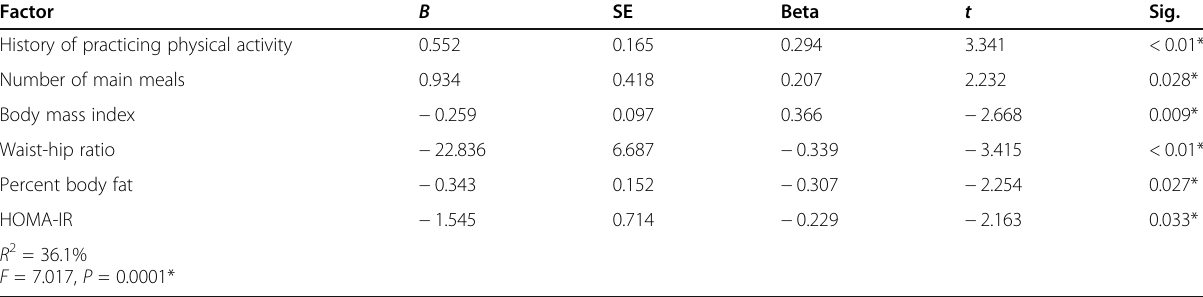
Table 3 Multiple regression analysis of variables associated with adiponectin level before the intervention Factor